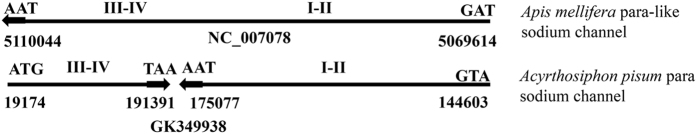
Genome positions of the Apis A. mellifera para-like sodium channel (upper panel) and Acyrthosiphon pisum. para sodium channel (lower panel) gene.